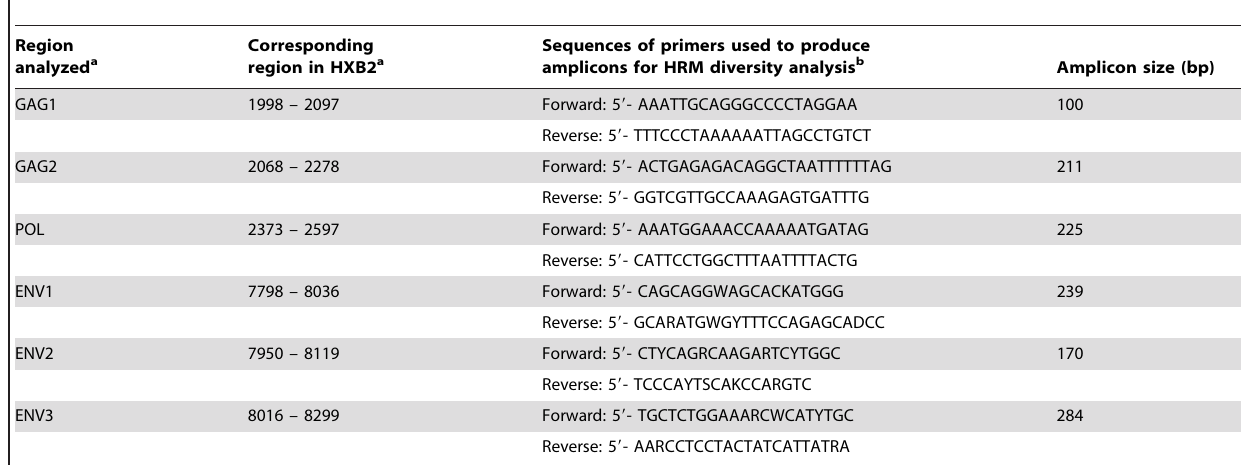
Table 1. Regions of the HIV genome analyzed using the high resolution melting (HRM) diversity assay.